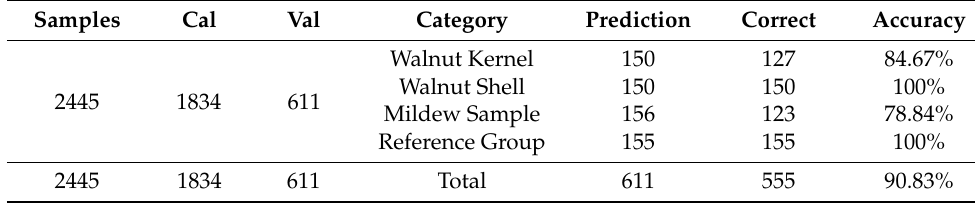
Table 1. Classification results of SVM discriminant model.